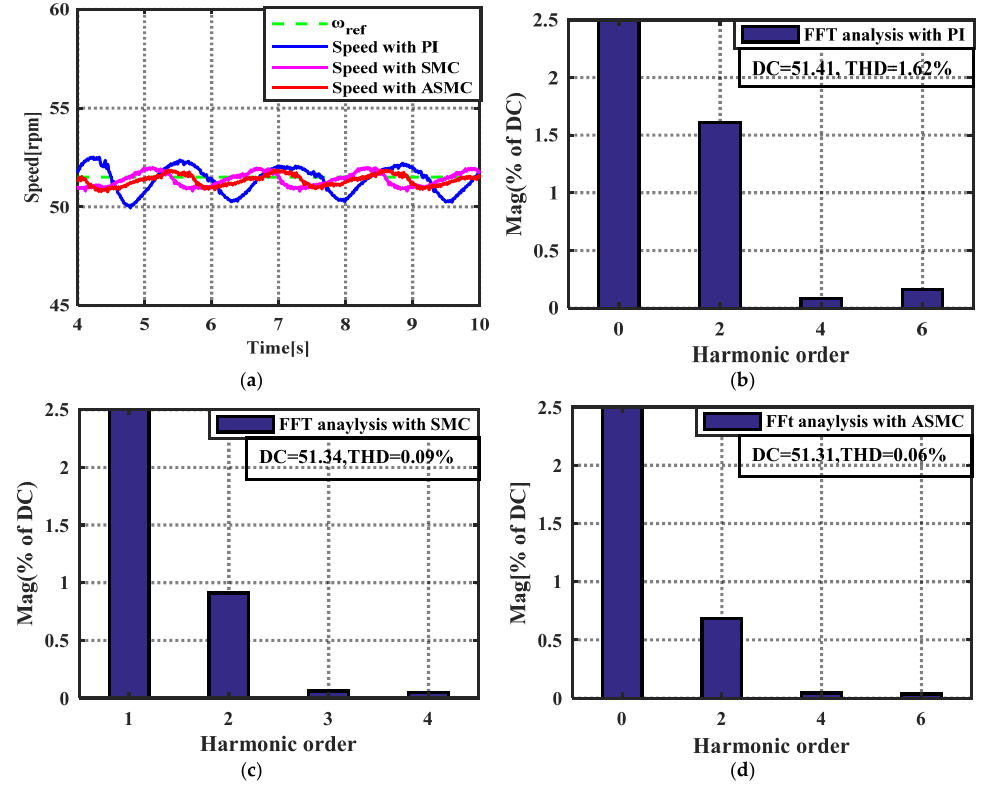
Figure 14. Steady state performance of the speeds and their FFT analysis. ( a ) Speed curves using